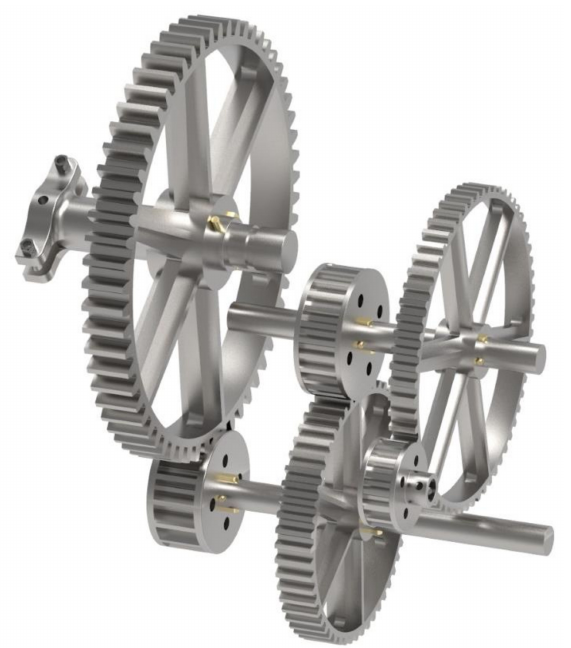
Figure 17. Gear train